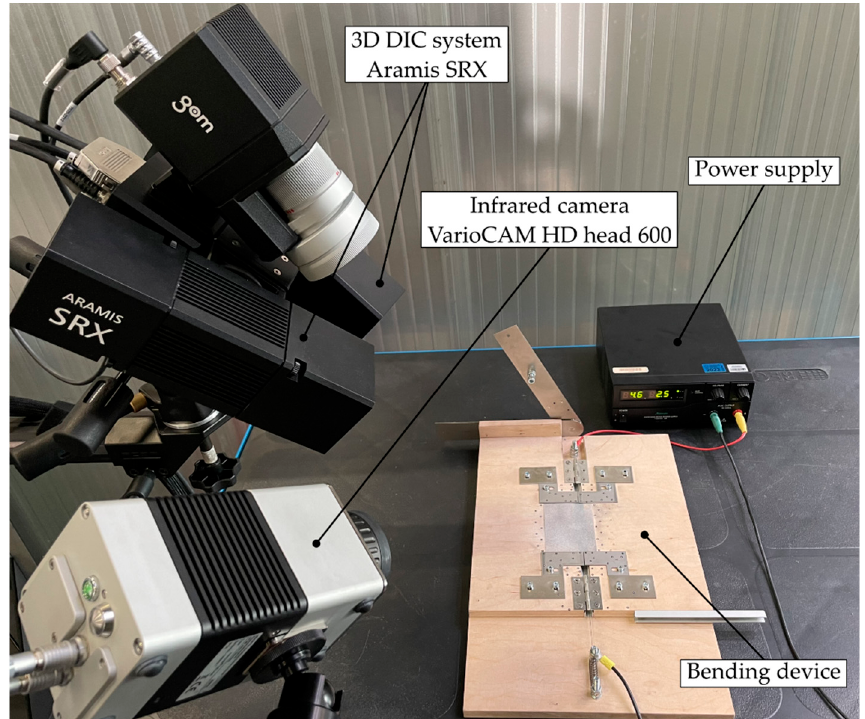
Figure 4. Experimental setup for deformation quantification and synchronous acquisition of the temperature field during the bending process.